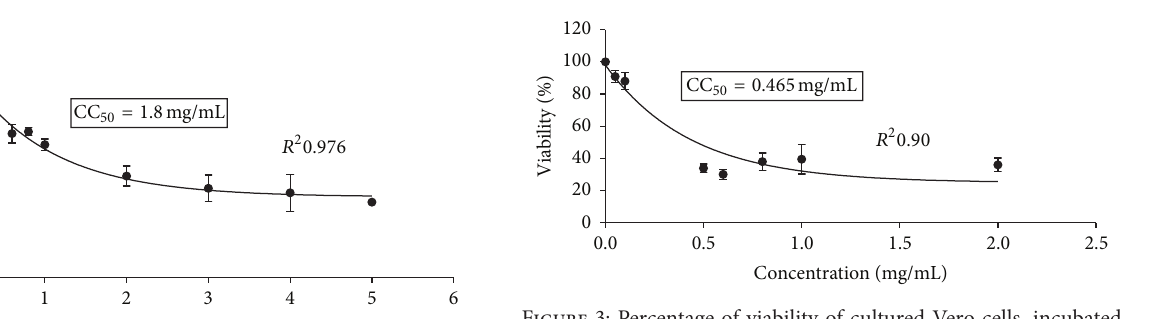
Figure 3: Percentage of viability of cultured Vero cells, incubated for 48 h in the presence of ethanolic extract (EE) of Acacia aroma employed at different concentrations determined by neutral red uptake (NRU). Each point represents the mean of four independent trials. CC 50 was 0.465